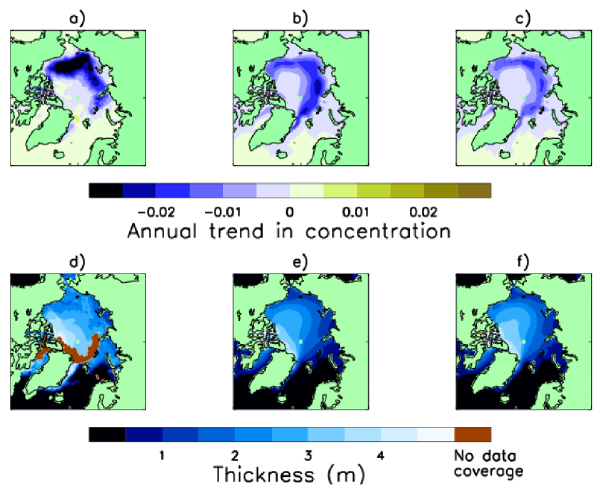
Fig. 2. (a–c) show linear trend in September ice concentration (yr − 1 ) from 1979–2011 in the HadISST observations, and in the HadGEM1 ALL and ANT ensembles respectively. (d–f) show mean ice thickness from 1994–2000 in a superposition of satellite and submarine observations from that period (described more fully in Appendix A), and in the ALL and ANT ensembles